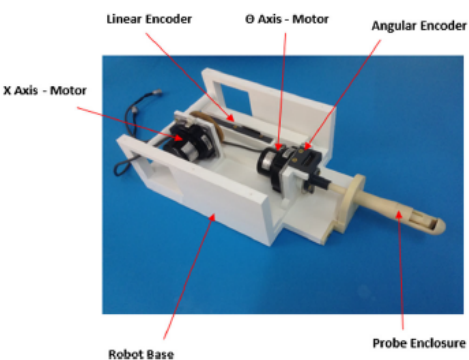
Figure 15. System by Epaminonda et al. for the treatment of gynecologic tumors